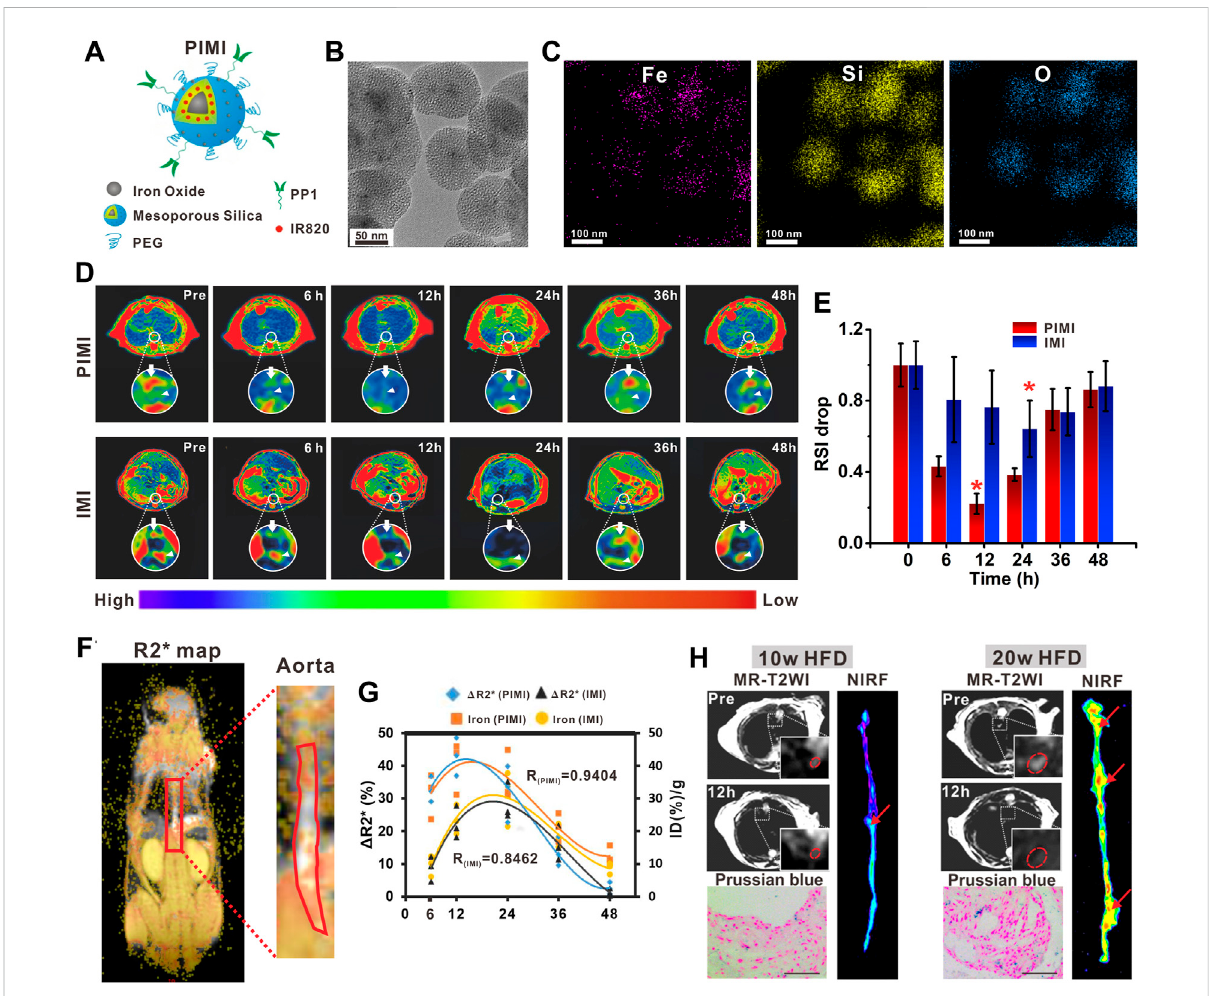
FIGURE 1 (A) Schematic illustration of PIMI. (B) TEM image and (C) elemental mapping images (Fe, Si, and O) of PIMI. (D) T 2 -weighted pseudo-color imagesafterPIMIandIMInanoparticleinjection. (E) RelativeMRsignalintensitydropofaorticplaquesatdifferenttimepoints. (F)